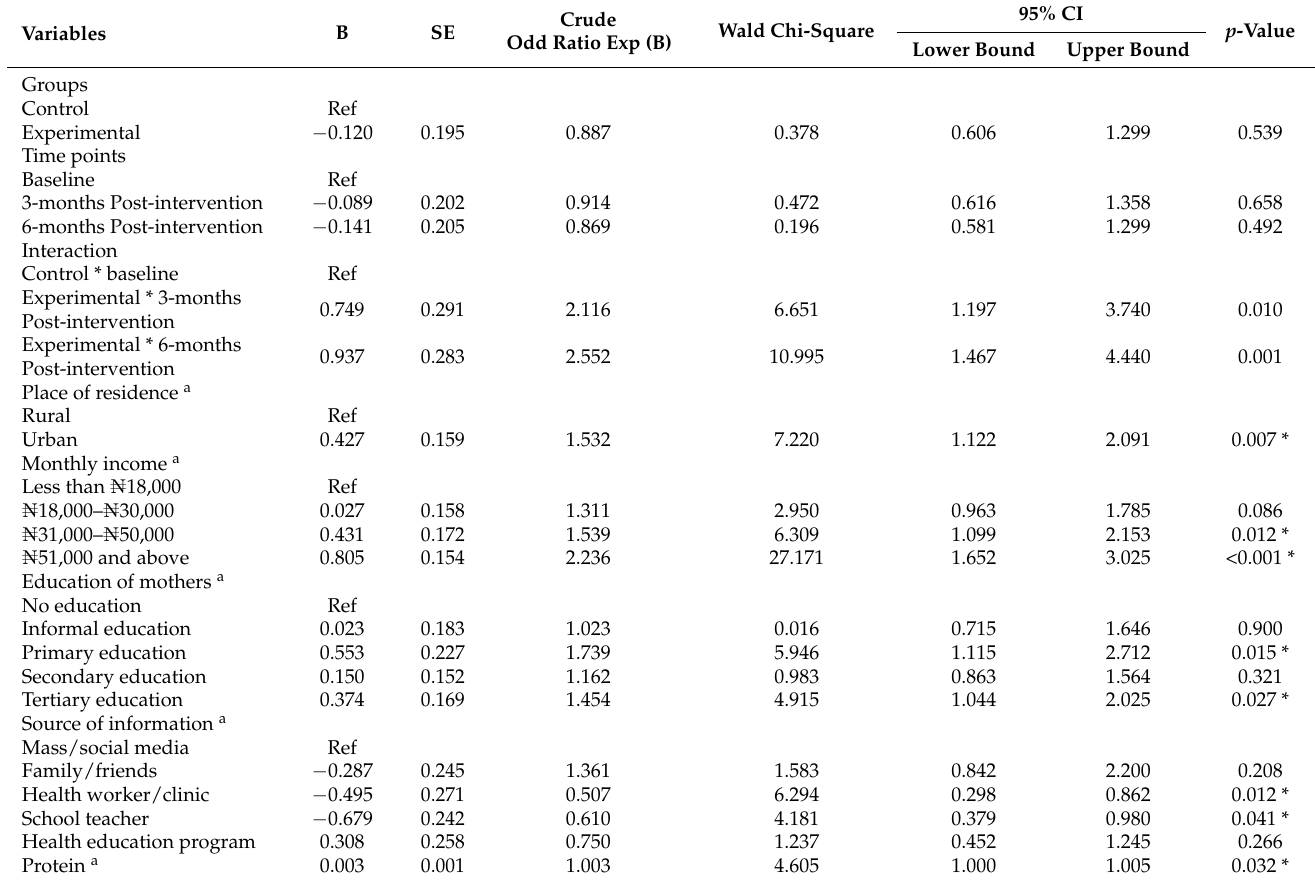
Table 9. Effectiveness of Triple Benefit Health Education Intervention on Food Security towards Malnutrition between Groups (intervention and control) and Time Points (baseline, 3 and 6-months post-intervention) adjusted with Covariates using